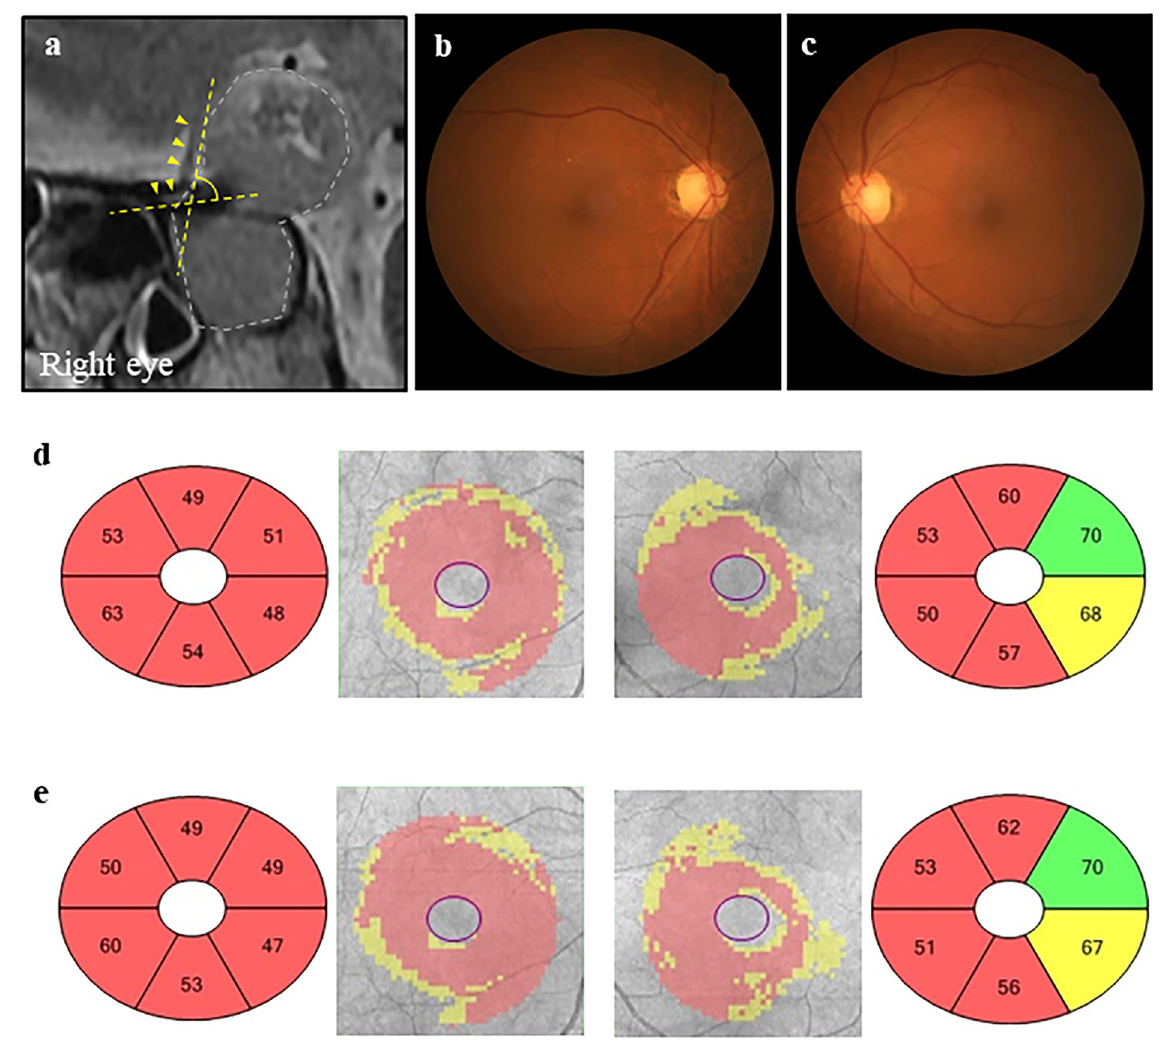
Figure 6. Representative clinical findings of a case with poor visual outcome (case 2). A 74-year-old man with pituitary adenoma with optic nerve bending in the right eye. The preoperative and postoperative best-corrected visual acuities (BCVAs) were 0.82 and 0.10 in the right eye and 0.70 and − 0.08 in the left eye logarithm of the minimum angle of resolution units, respectively. ( a ) Preoperative sagittal T2-weighted magnetic resonance images. The angle indicated by yellow dotted lines is the optic nerve–canal bending angle (ONCBA); yellow arrowheads indicate optic nerve, and white dotted lines indicate a tumor. The ONCBAs of this case were 73° in the right eye and 39° in the left eye. Therefore, the right eye is the one with optic nerve bending. ( b , c ) Color fundus photograph showed normal appearance at preoperative visit (B, right eye; C, left eye). ( d , e ) Ganglion cell layer (GCL) + inner plexiform layer (IPL) deviation map and sector graph of the right eye (left 2 panels) and left eye (right 2 panels) ( d , preoperative; e , postoperative visit). A decrease in preoperative GCL + IPL thickness of the right eye is observed in all sectors. A decrease in preoperative GCL + IPL thickness of the left eye is observed in the predominantly nasal region. Postoperative GCL + IPL thickness in almost all sectors was more unremarkable than preoperative GCL + IPL thickness in both